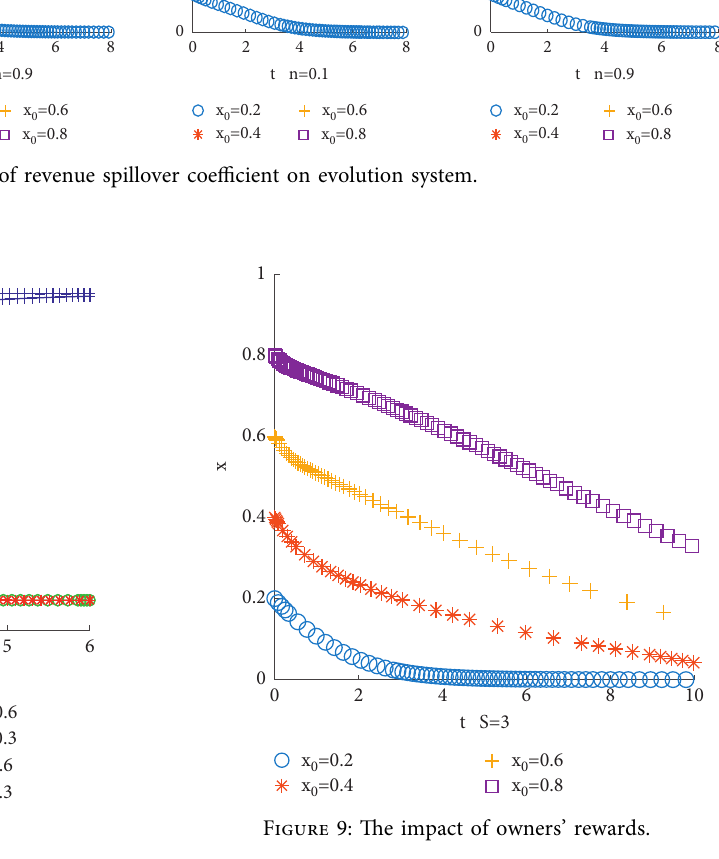
Figure 8: The impact of owners’ intervention.